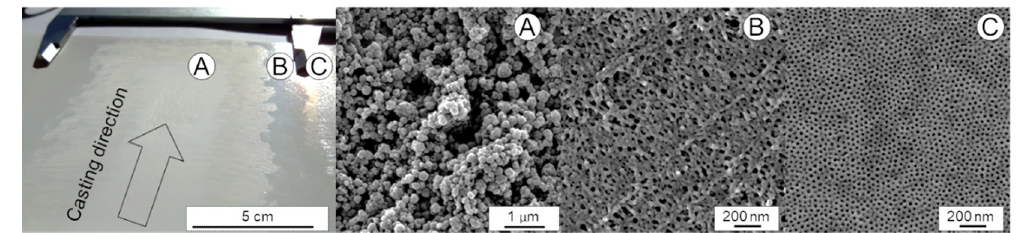
Figure 11. Spray cast sample of PS 83 - b -P4VP 1788 solution in 1,4-dioxane with a 1-fluid nozzle (6H), 2.5